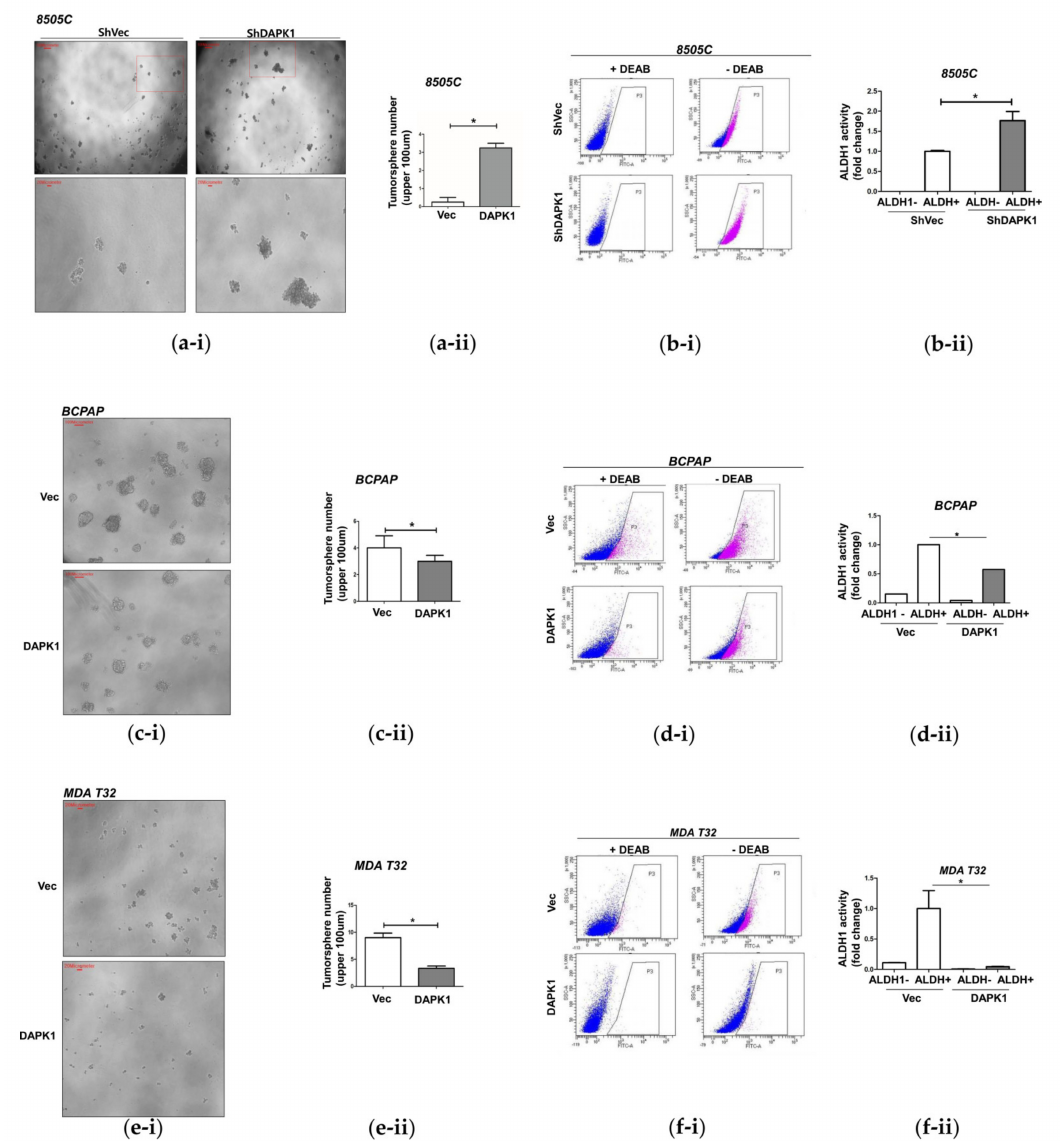
Figure 3. DAPK1 is associated the migration and invasion ability of 8505C, MDA-T32, and BCPAP cancer cells. ( a-i ) DAPK1 is associated with the stemness of thyroid cancer cells. ( a , b ) After 10 days of tumorsphere formation using shVector- and sh DAPK1 - 8505C cells in low-attachment 6-well plates, the number of tumorspheres ( a ) and ALDH1 activity ( b ) were measured. ( a-i ) Compared with the control, the sh DAPK1 8505C cells showed a significant increase in tumorsphere formation ability. ( a-ii ) Quantification of ( a-i ). ( b-i ) ALDEFLUOR assay was used to determine ALDH1 activity. Compared with the control, ALDH1 expression increased significantly in the stable sh DAPK1 - 8505C cells. ( b-ii ) Quantification of ( b-i ). ( c , d ) After 10 days of tumorsphere formation using GFP-Vector and GFP- DAPK1 BCPAP cells in low-attachment 6-well plates, the number of tumorspheres ( c ) and ALDH1 activity ( d ) were measured. ( c-i ) Compared with the control, the stably overexpressing DAPK1 BCPAP cells showed a significant increase in tumorsphere formation ability. ( c-ii ) Quantification of ( c-i ). ( d-i ) ALDEFLUOR assay was used to determine ALDH1 activity. Compared with the control, ALDH1 expression decreased significantly in the stably overexpressing DAPK1 BCPAP cells. ( d-ii ) Quantification of ( d-i ). [24] After 10 days of tumor formation using GFP-Vector and GFP- DAPK1 MDA-T32 cells, the number of tumorspheres ( e ) and ALDH1 activity ( f ) were measured. ( e-i ) Compared with the control, the stably overexpressing DAPK1 MDA-T32 cells showed a significant increase in tumorsphere formation ability. ( e-ii ) Quantification of ( e-i ). ( f-i ) ALDEFLUOR assay was used to determine ALDH1 activity. Compared with the control, ALDH1 expression decreased significantly in DAPK1 -overexpressing BCPAP cells. ( f-ii ) Quantification of ( f-i ). Asterisks ( p < 0.05 [*]) indicate significant differences in the statistical analyses. Each data point represents the mean ± standard error of three independent